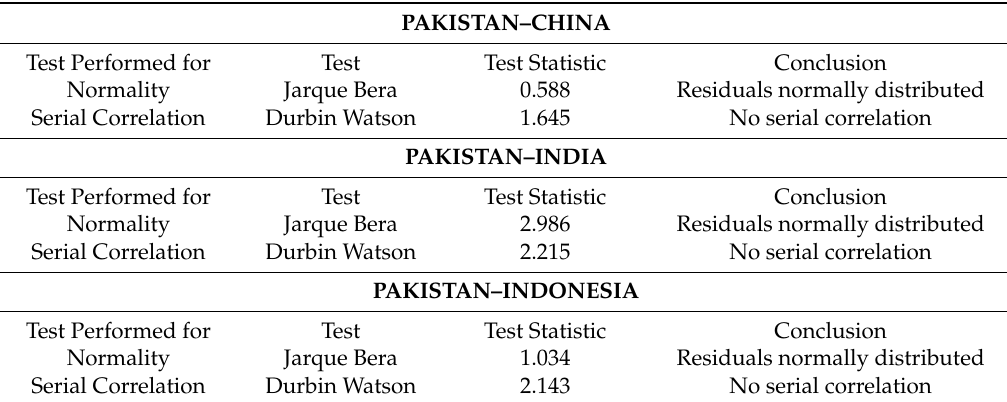
Table 11. Country-wise Diagnostic